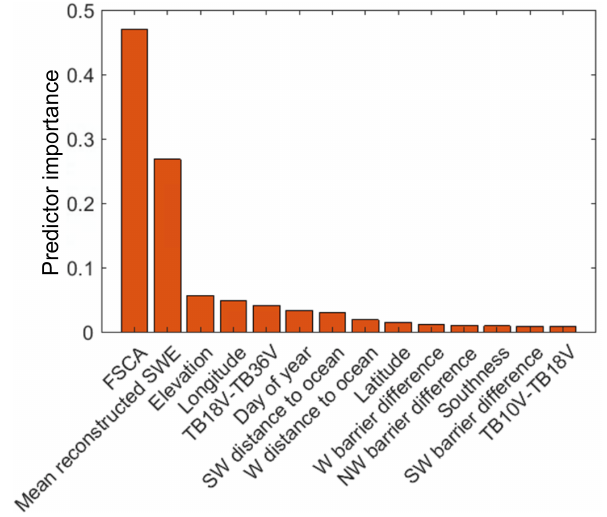
Figure 10. Predictor importance (see Sect. 3.5.3) for randomly se- lected observations across all years using bagged regression